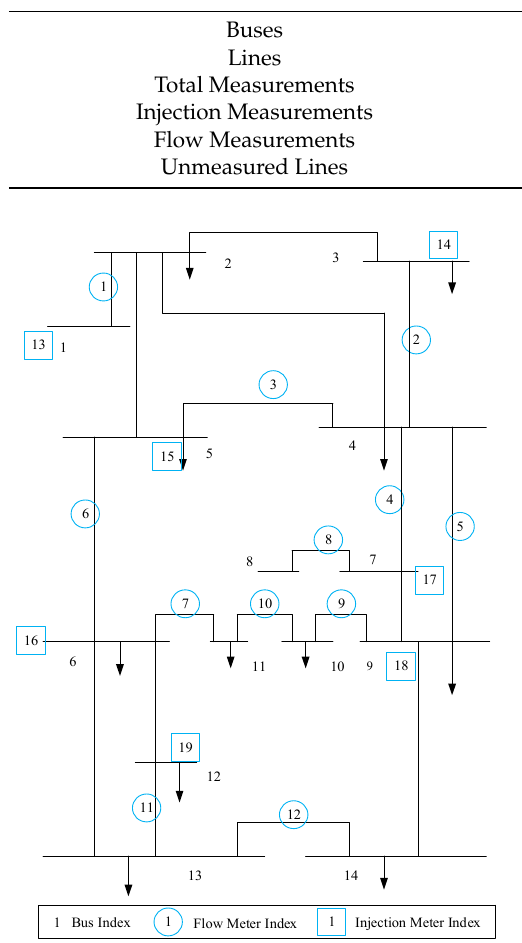
Table 2. SSA optimized hyperparameters of the CNN model.